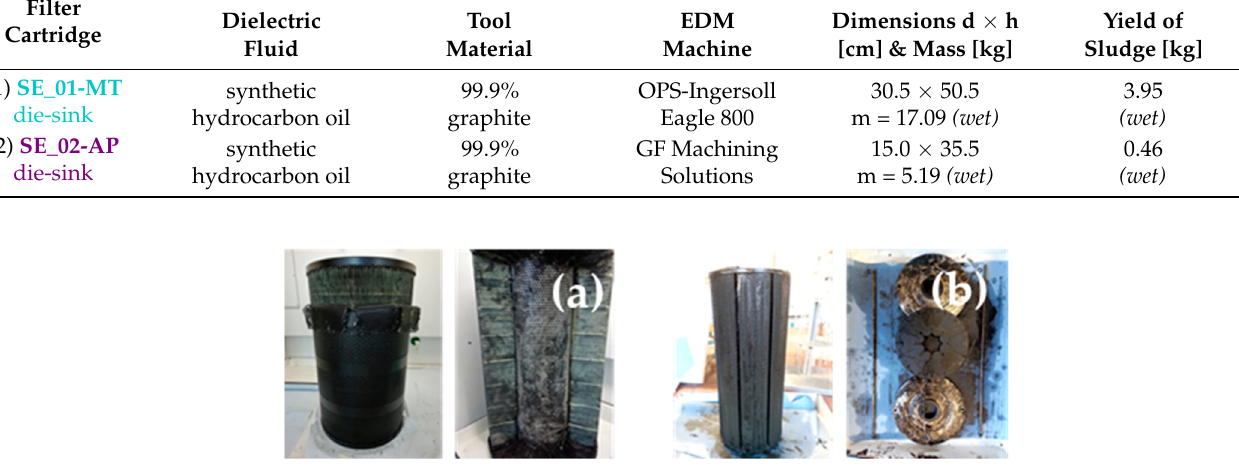
Figure 4. Flow sheet of dismantling, extraction of waste debris/sludge, example for SE_01. After filtration, the particles were washed again in acetone and/or isopropanol and finally dried in an oven overnight at 80 °C. As a side effect of the filtration processes, effects of sedimentation behavior were investigated. With time, the heavier steel particles settled at the bottom of the flasks and the supernatant solution containing the lighter par- ticles and most of the graphite was decantated, resulting in two different fractions of par- ticles for further characterization, which were mostly graphitic flakes of the filter cake on the paper, and metallic residues in the glass flasks. Measurements with laser diffraction, permanently with cuvette R3, and with dy- namic image analysis in 300 mL liquid with a stirrer at 600 rpm and pump speed at 65 rpm (HELOS and QICPIC LIXELL, both Sympatec GmbH, Clausthal-Zellerfeld, Ger- many) were carried out to quantify particle size and shape, especially circularity, in a dry or wet (dispersed in isopropanol and/or DI water) state. The initial sludge could be sus- pended in isopropanol with ultrasound assistance (3 min, 50% amplitude, cycle 1) and was measured with laser diffraction as well to compare size values before and after filtra- tion and cleaning procedures. All of the following investigations were performed with